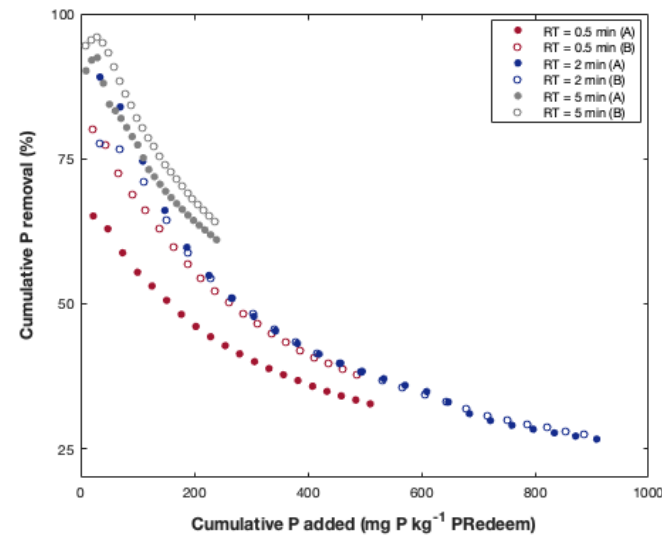
Figure A1. Phosphorus (P) removal by PhosRedeem in flow-through experiments using different residence times (RT). Experiments were performed with input solution of 0.5 mg P L − 1 .